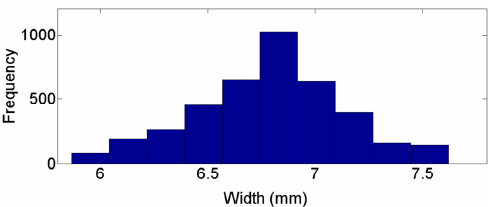
Figure 13. Real-time height measurement for a work point of 21 V and 6 m/min, using a welding speed of 10 mm/s and 100 fps as sampling rate [22]. Figure 14. Frequency distribution for width measurements with a work point of 21 V and 6 m/min.